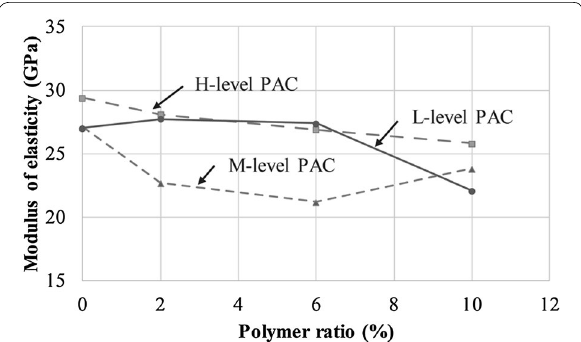
Fig. 19 Shrinkage strains of concrete samples with 2, 6, or 10% polymer